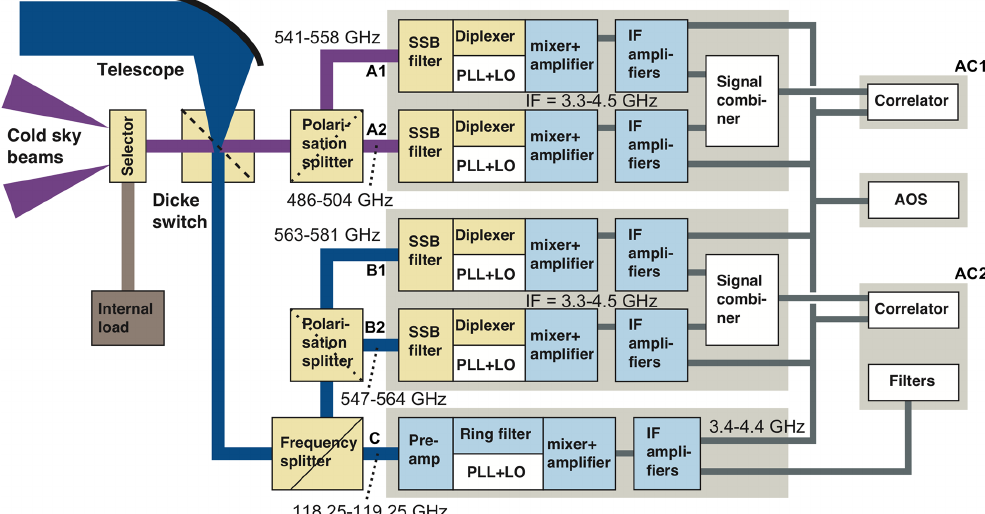
Figure 1. Block diagram of the Odin radiometer from Frisk et al. (2003). Table 1. Characteristics of the FMs used to observe mesospheric H 2 O and temperature from Rydberg et al. (2017). Spectrometer Frontend LO